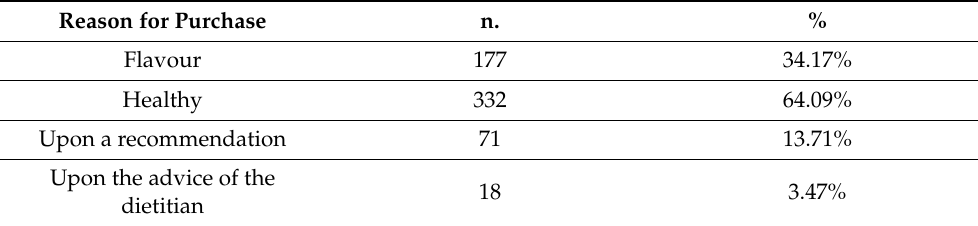
Table A7. Reason of purchase of legume-based snack (in % of